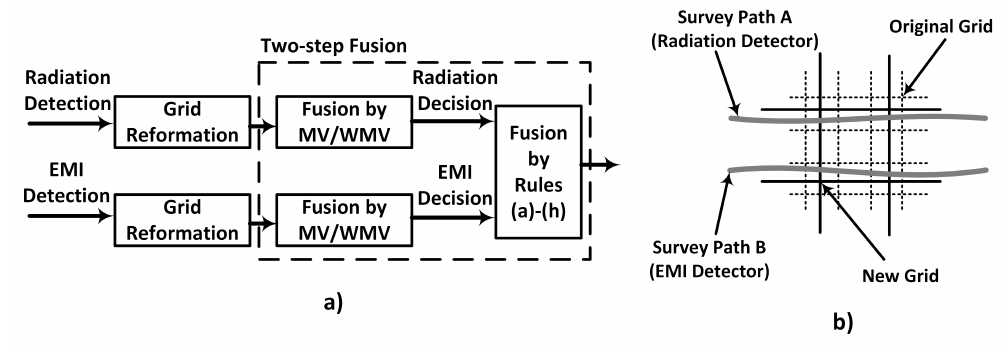
Figure 8. ( a ) Decision-level fusion framework for radiation and electromagnetic induction (EMI) data fusion (MV = mean vote, WMV = weighted mean vote); ( b ) re-gridding of the survey area